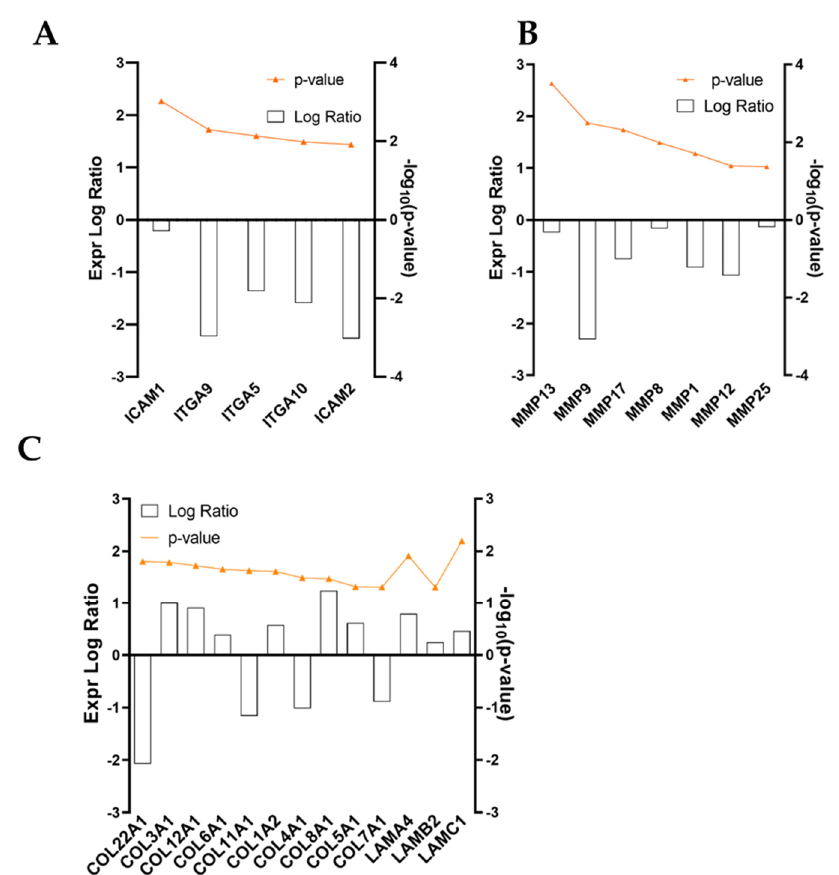
Figure 5. ( A – C ) Expression logarithmic ratios of differentially regulated genes from the w/ TNF α microarray involved in ECM maintenance. Expression is displayed as a bar, while significance, expressed as − log10( p -value), is reported in orange.